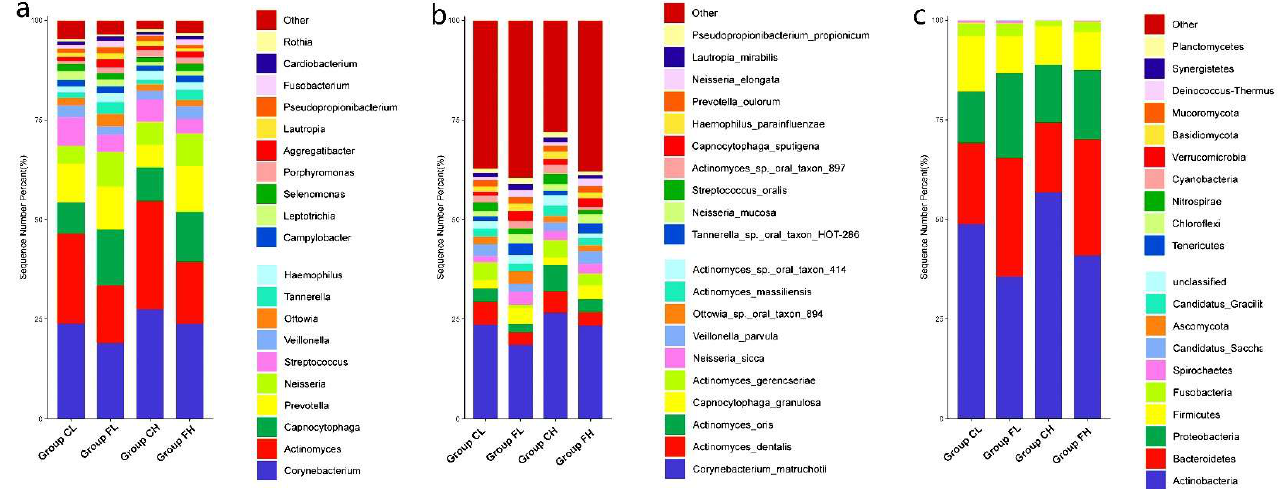
Figure 1. Relative abundance of the 20 most predominant ( a ) phyla, ( b ) genera, and ( c ) species among